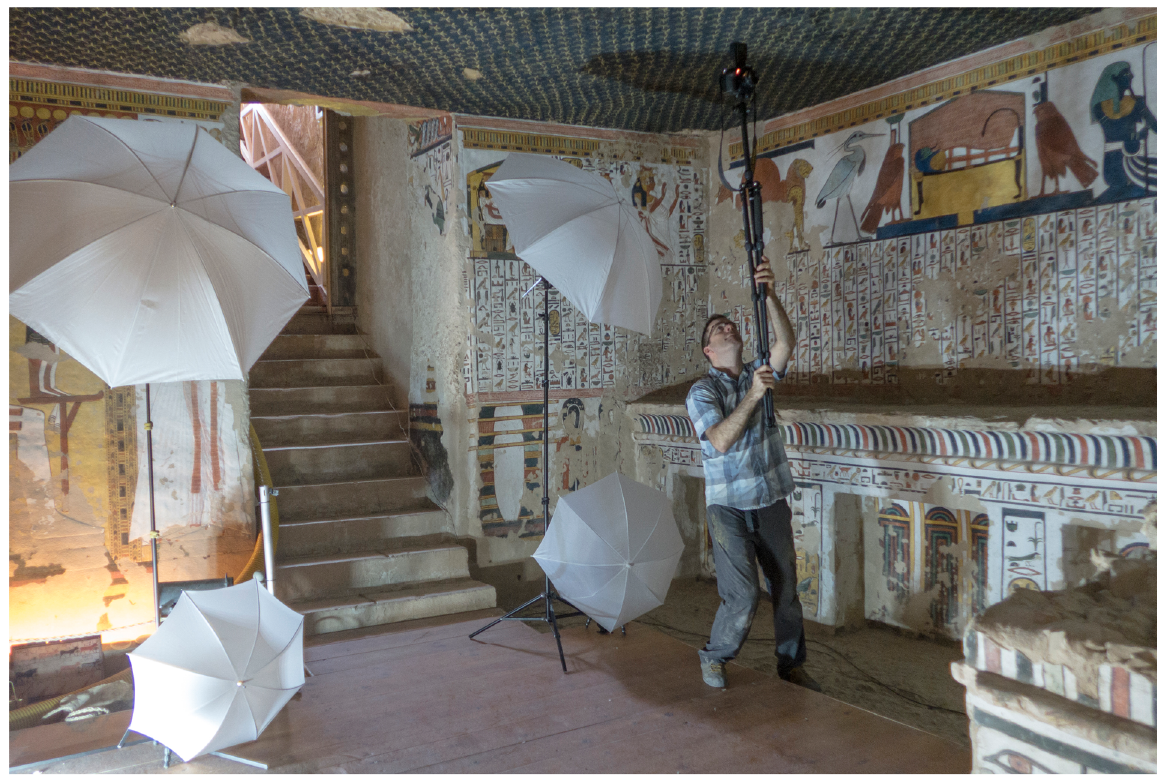
Fig. 5 Recording decorated surfaces in the valley of the Queens, Luxor Egypt (2017) (Source: the